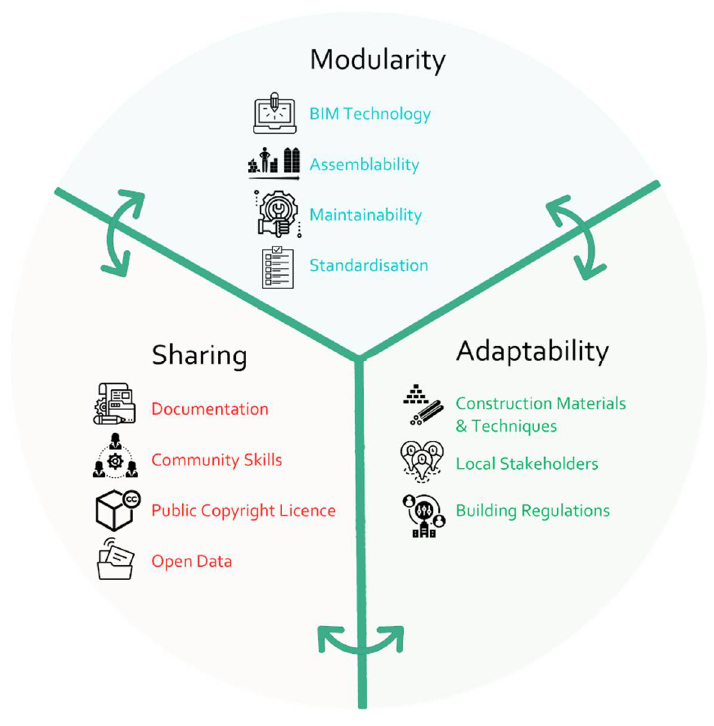
Figure 3. Conviviality features of OCSs.